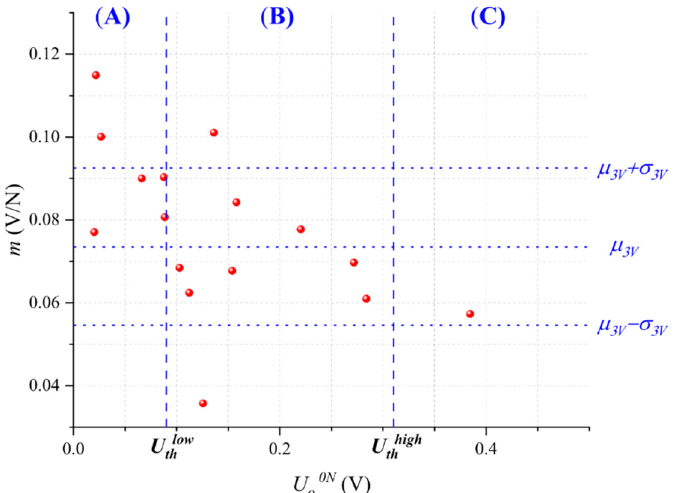
Figure 8. Sensitivity ( m ) as a function of the output voltage at null force ( U o0N ) for the sixteen specimens of the control stage. Data were taken at U = 3 V.